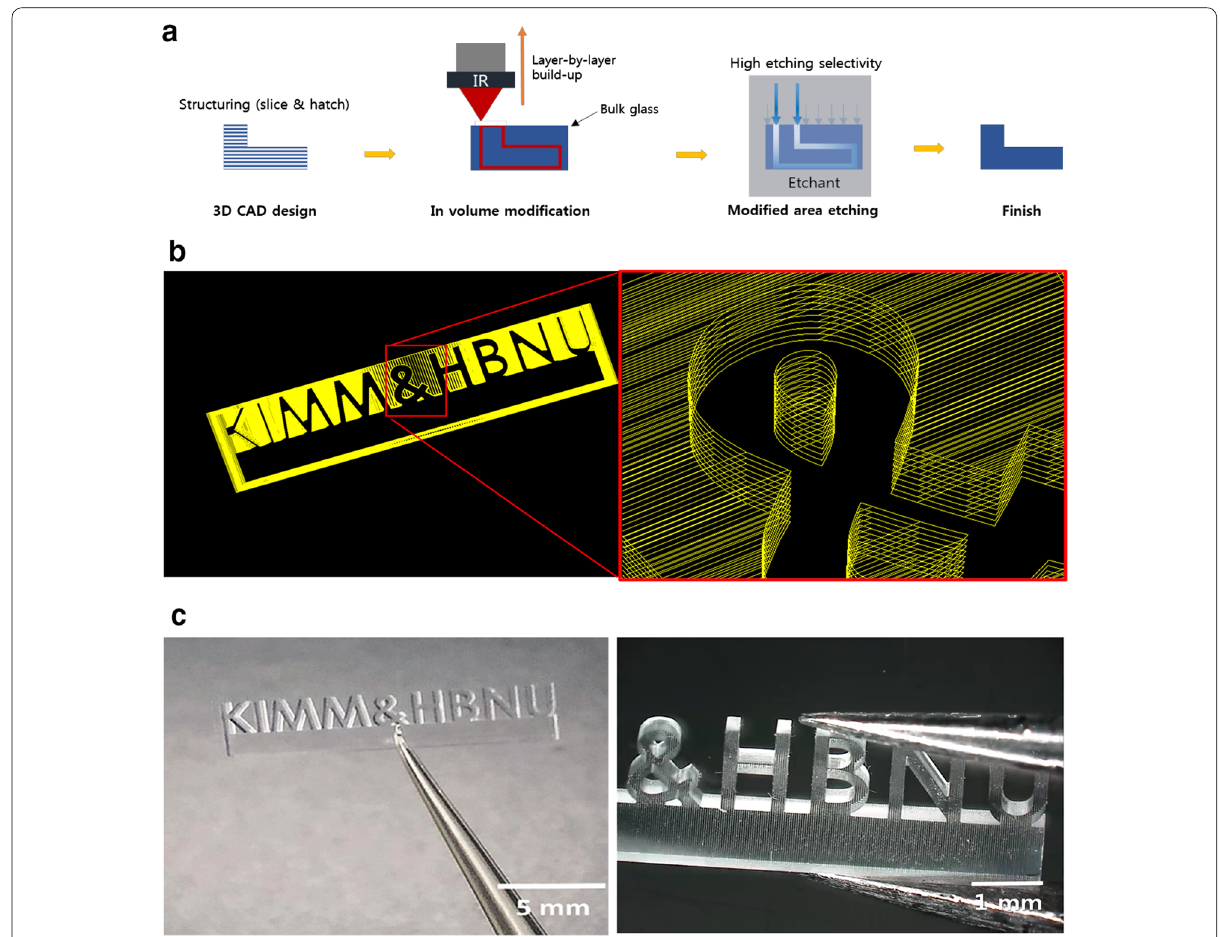
Fig. 2 a Schematic diagram of the SLE process for 3D structures, b STL file format with slice and hatching line, c pictures of the fabricated 3D alphabet